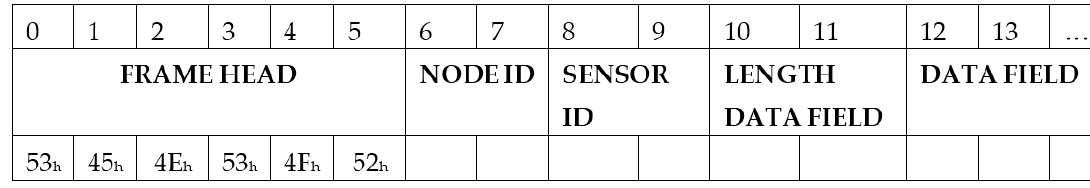
Figure 6. Structure of data packet sent by the sensor nodes.